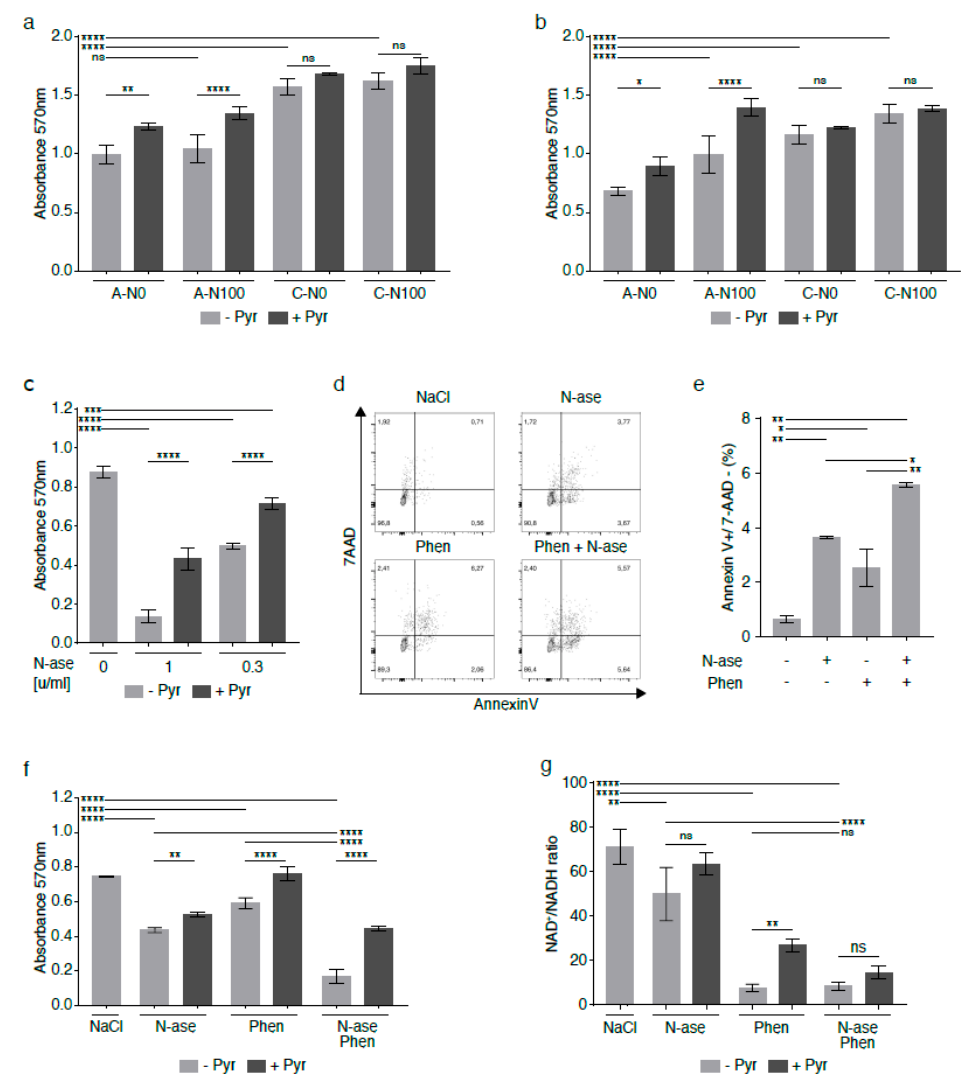
Figure 7. Synergistic growth-inhibitory effects of phenformin and asparaginase on human RD rhabdomyosarcoma cells . In the human rhabdomyosarcoma cell line RD, asparagine deprivation by shASNS knockdown and culture in asparagine-free medium reduced proliferation in ( a ) supraphysiological glutamine conditions and in ( b ) physiological glutamine conditions. ( a , b ) The anti-proliferative effects of asparagine deprivation were reversed by supplementation with exogenous asparagine in ( b ) a physiological glutamine, but not ( a ) a supraphysiological glutamine, environment.